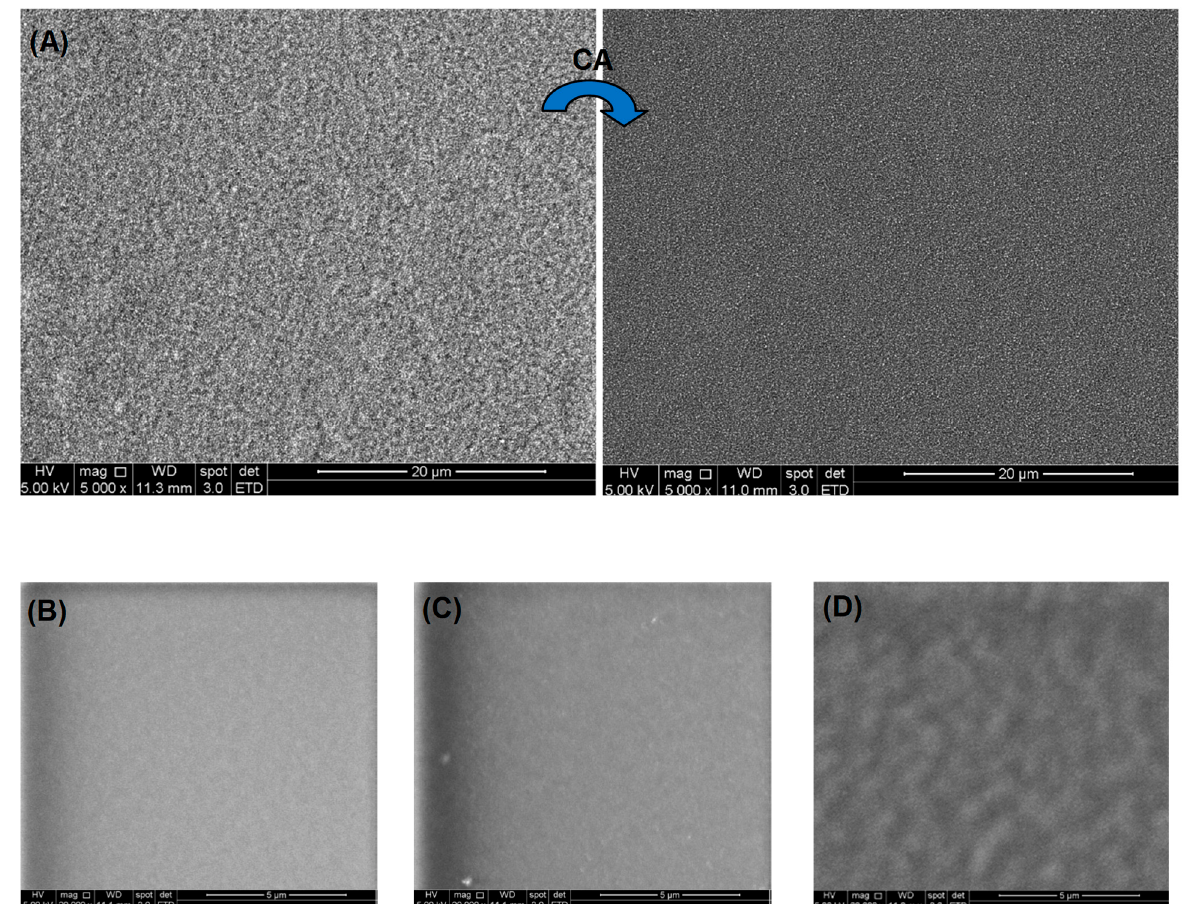
Figure 12. ( A ) SEM images of CMC-700:PVA blend before ( left side , CA0) and after ( right side , CA25) crosslinking reactions (5000×, scale bar = 20 μ m). SEM images of crosslinked ( B ) CMC- crosslinking reactions (5000 × , scale bar = 20 µ m). SEM images of crosslinked ( B ) CMC-250_CA20, 250_CA20, ( C ) PVA_CA20, and ( D ) CMC-700:PVA_CA25 (20,000×, scale bar = 5 μ m). ( C ) PVA_CA20, and ( D ) CMC-700:PVA_CA25 (20,000 × , scale bar = 5 µ